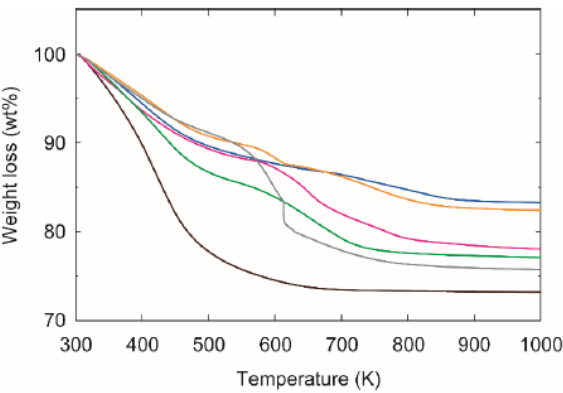
Figure 5. TG curves of non-modified (black), MTES-modified (blue), APTES-modified (red), PTES- modified (green), MPTMS-modified (orange), and GPTMS-modified (gray) FAU-type zeolite particles.